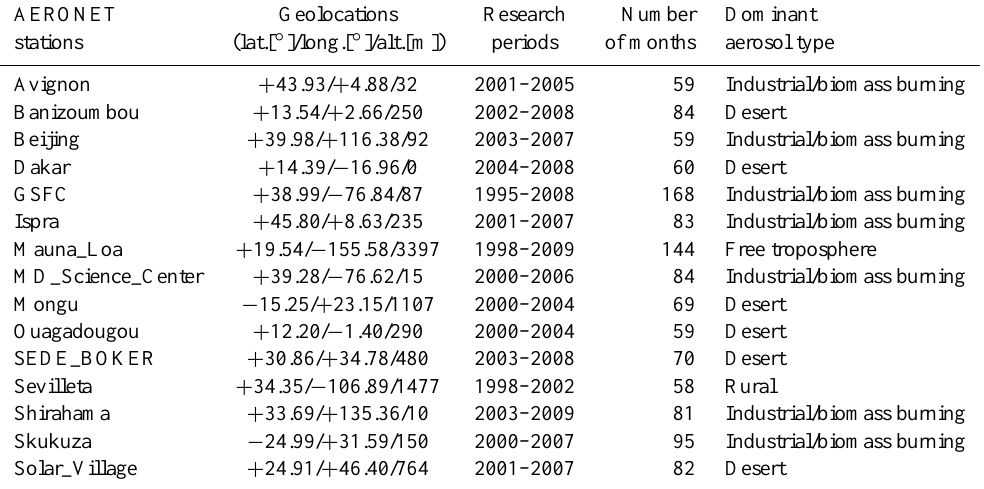
Table 2. The AERONET stations classified by regional dominant aerosol types (Yoon et al., 2012) for the investigation of the temporal pattern correlation in Fig. 3. The AERONET stations are selected using the criterion that the minimum length of the data set is 5 years (Yoon et al.,